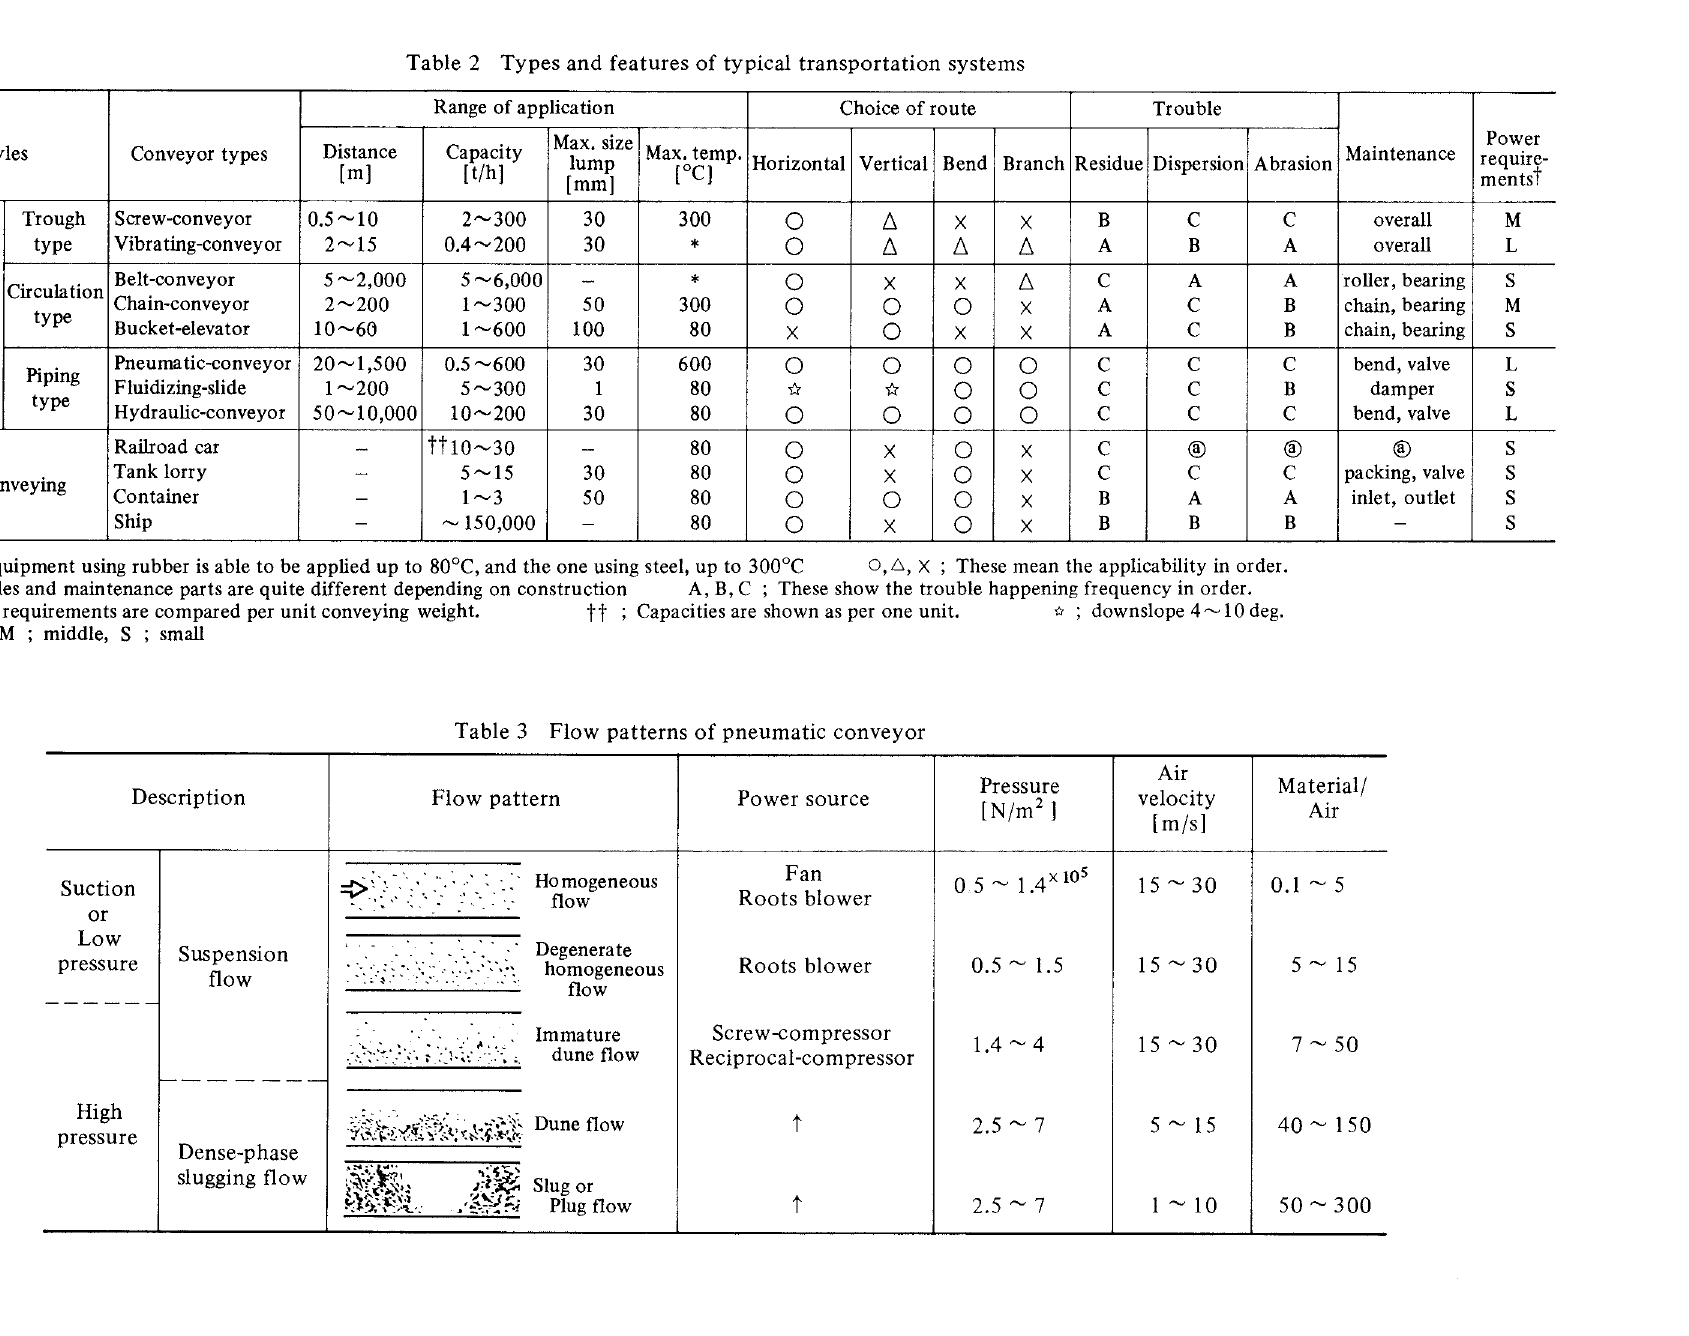
Table 2 Types and features of typical transportation systems